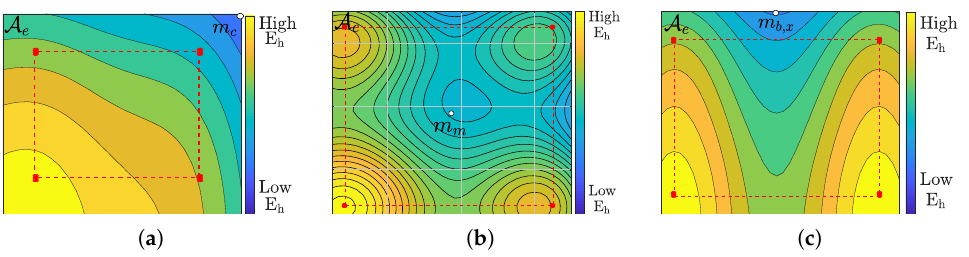
Figure 7. Illumination patterns having the minimum ( a ) in the corner m c of the considered area, ( b ) close to the centre m m of the four arrays, ( c ) on the boundary of the considered area, approximately halfway between the two nearest arrays (here m b , x